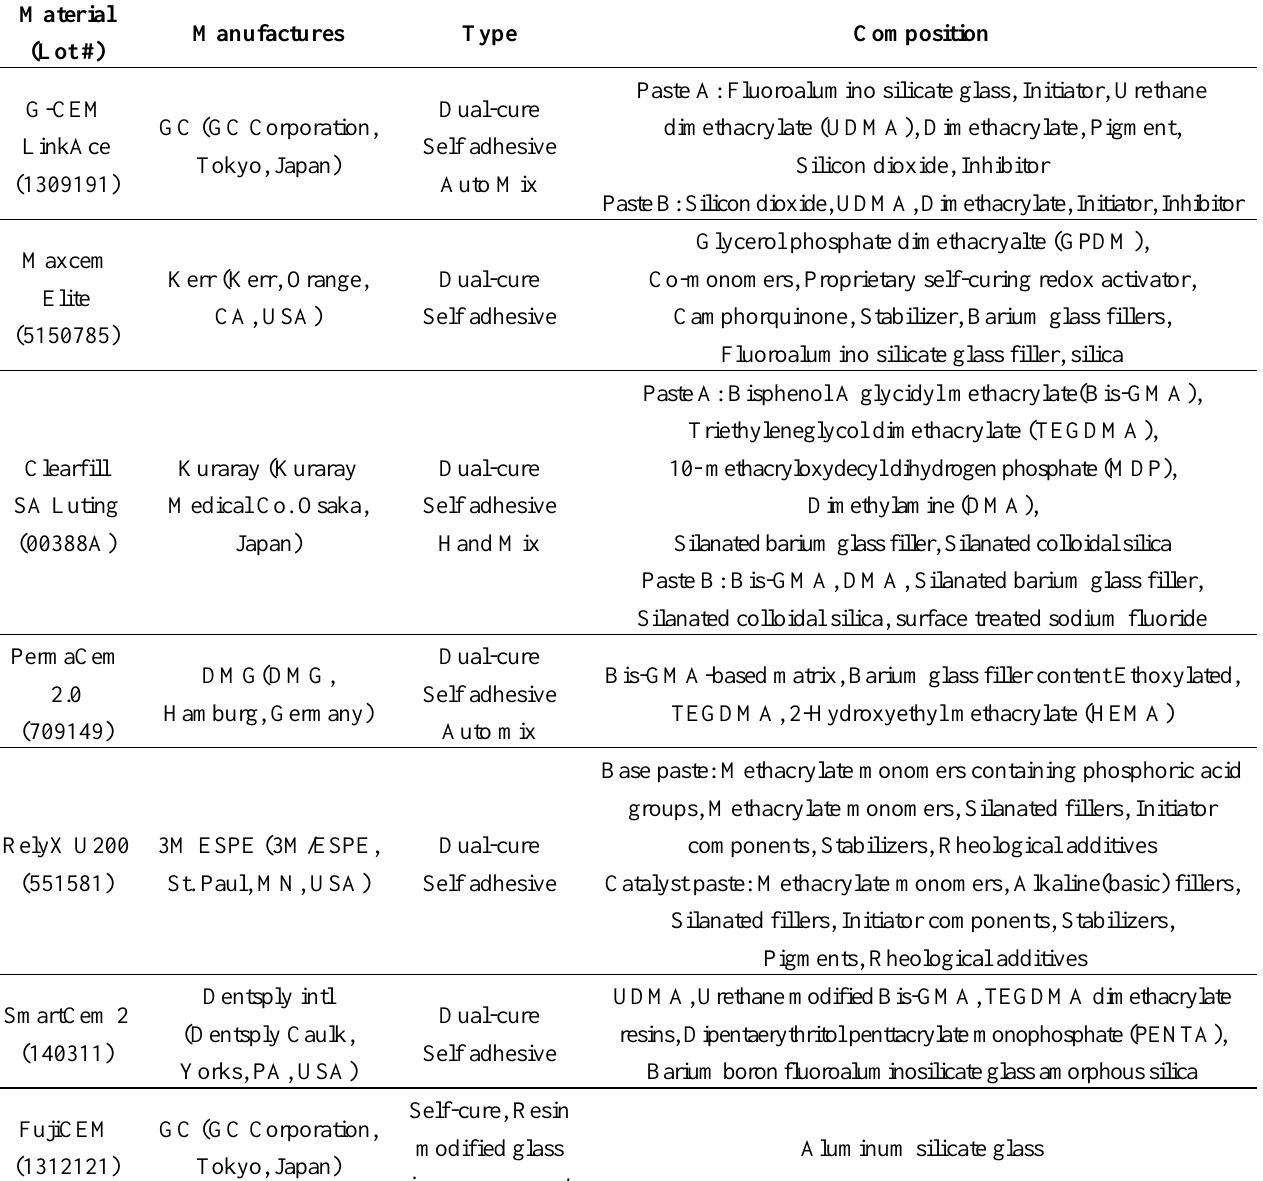
Table 2. Tested materials, type, and